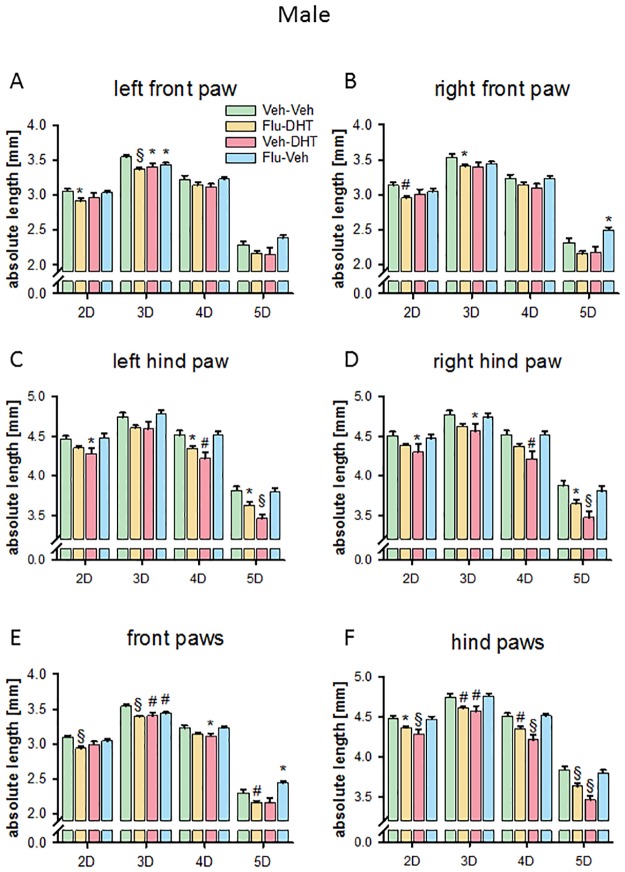
Absolute finger length is altered by prenatal treatment in male mice.Length of digits on the left (A) and the right (B) front paw. Length of digits on the left (C) and the right (D) hind paw. (E) Digit length of pooled (left + right) front paws. (F) Digit length of pooled (left + right) hind paws. Data represented as mean ± Standard error of the mean (SEM). * p<0.05, # p<0.01 and § p<0.001 compared to control. Veh—Vehicle; Flu—Flutamide; DHT—Dihydrotestosterone.